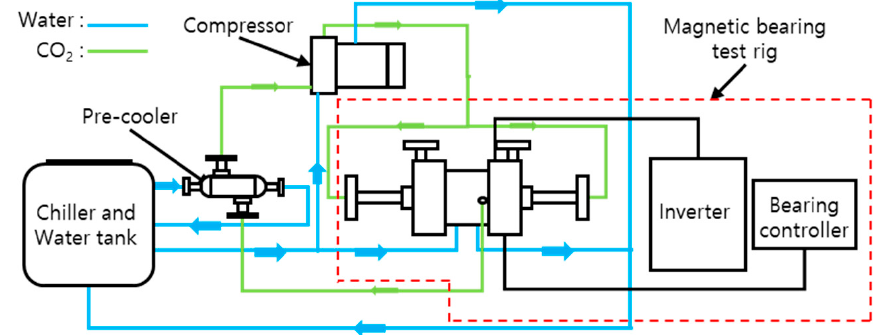
Figure 14. Layout of the magnetic bearing instability experiment.